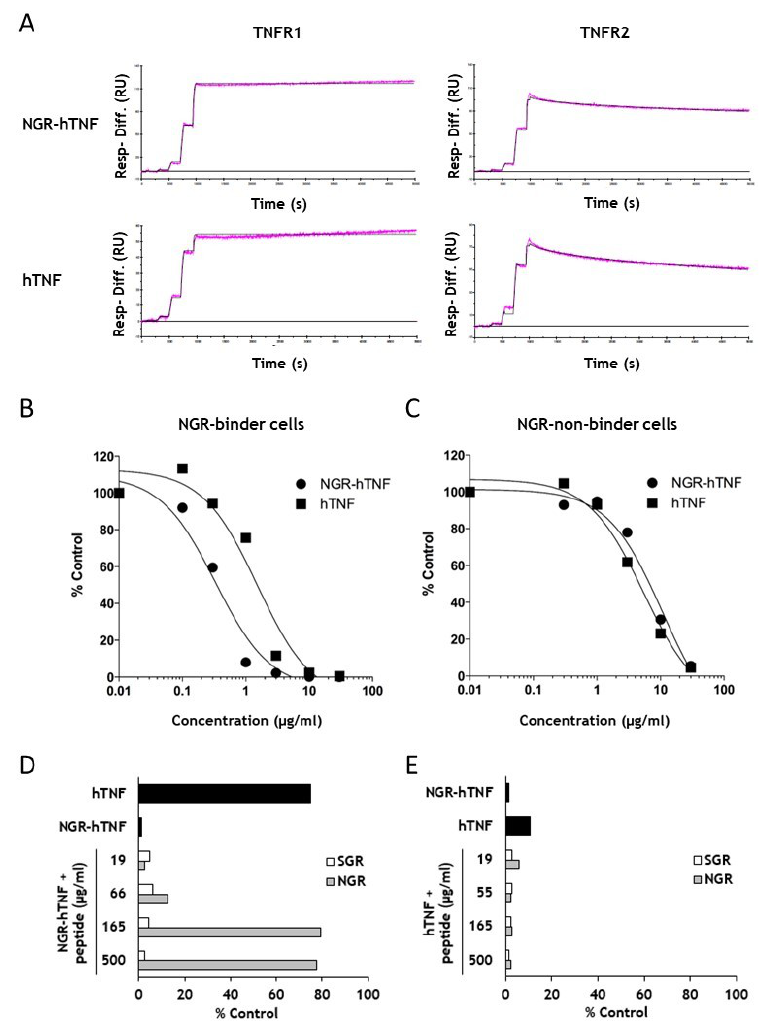
Figure 3. In vitro characterization of the binding properties of NGR-hTNF. ( A ) Sensograms of hTNF and NGR-hTNF kinetic titration on TNFR1 and TNFR2 ( B ) NGR-hTNF and hTNF efficiently compete the binding of hTNF-Fc in a semi-quantitative manner, but NGR-hTNF competes the hTNF-Fc binding to a greater extent than hTNF in CNGRC-binder cells (MR300). ( C ) NGR-hTNF and hTNF compete at the same extent the binding of hTNF-Fc to CNGRC-non-binder cells (GR4-mel). ( D ) On NGR-binder cells (MR300), the NGR-hTNF competition of the hTNF-Fc binding (black bar) is completely reverted by increasing concentrations of free CNGRC peptide (gray bars). As a control, competition with the unrelated CSGRC peptide is shown (white bars). ( E ) On NGR-binder cells (MR300), the competition exerted by hTNF on the hTNF-Fc binding (black bar) is not reverted by the addition of free CNGRC peptide (gray bars). As a control, competition with the unrelated CSGRC peptide is shown (white bars). The black bars in ( D , E ) indicates hTNF-Fc binding in the presence of NGR-hTNF or hTNF, expressed as percentage of control (i.e., hTNF-Fc alone).